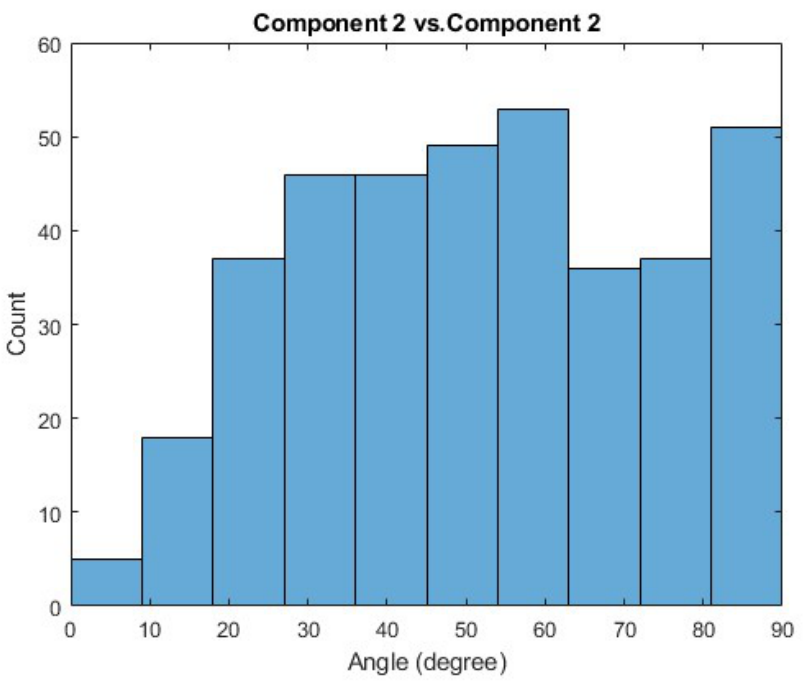
Figure A5. Histogram of the comparisons between the second principal component of some Trial A and the second principal component of some Trial B, where these comparisons are made across all trials and